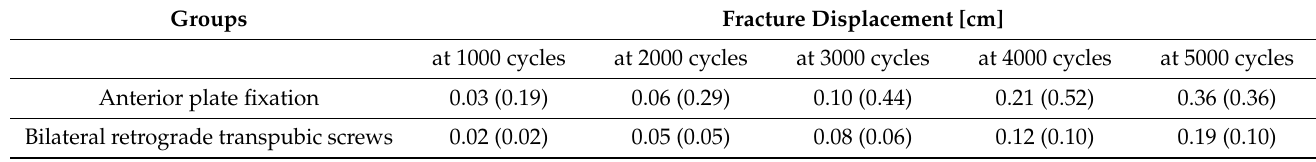
Table 2. Fracture displacement in the study groups after 1000, 2000, 3000, 4000 and 5000 cycles, presented in terms of median and interquartile range (the latter in